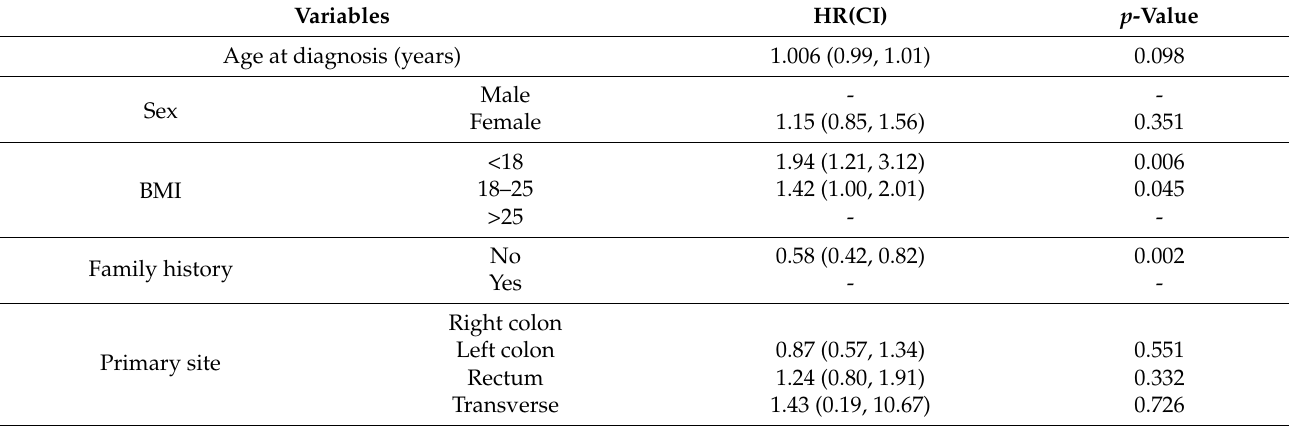
Table 2. Multivariable Cox model results to explore the effect of Factors associated with survival among patients with